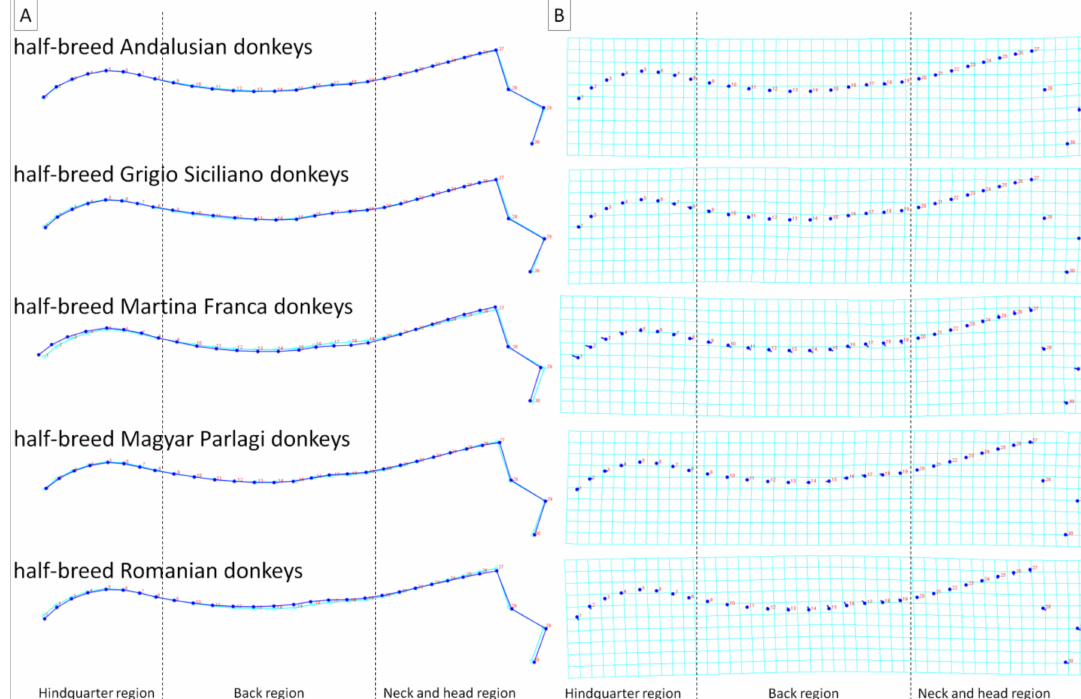
Figure 9. Average observations of the donkeys’ dorsal profiles grouped by breed (half-breed Andalusian donkeys, half-breed Grigio Siciliano donkeys, half-breed Martina Franca donkeys, half-breed Magyar Parlagi donkeys, and half-breed Romanian donkeys) and represented by ( A ) wireframe graphs and ( B ) a transformation grid. In the wireframe graphs, light blue landmarks and curves represent the consensus donkey’s dorsal profile and the dark blue landmarks and curves represent the average observations for the subsequent breed groups. On the transformation grid, dark blue landmarks represent the consensus donkey’s dorsal profile and the dark blue lines represent the average observations for the subsequent breed groups. Dashed lines indicate the boundaries between the regions. Consecutive landmarks are marked with increasing numbers from the first caudalis vertebra (1) to the tuber faciale